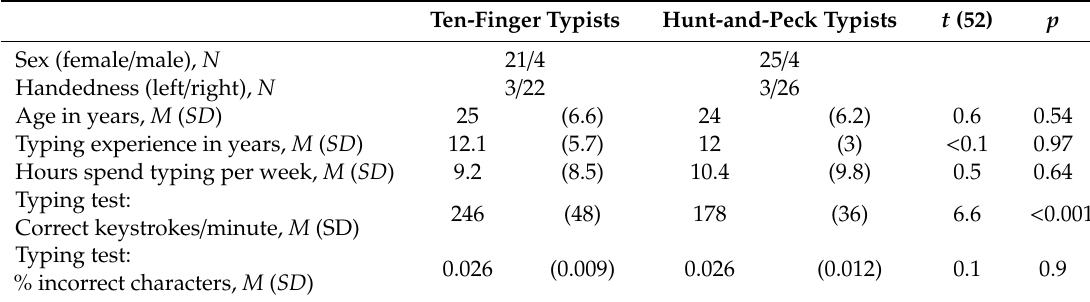
Table 1. Demographic data and data related to typing experience. The typing test consisted of 670 characters including